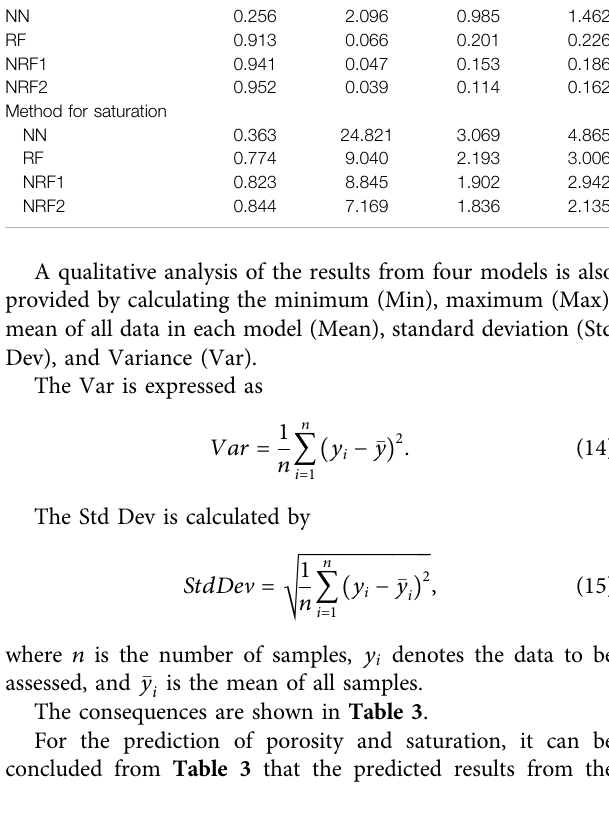
TABLE 2 | Qualitative analysis of predicted porosity and saturation results from four models. Method for porosity